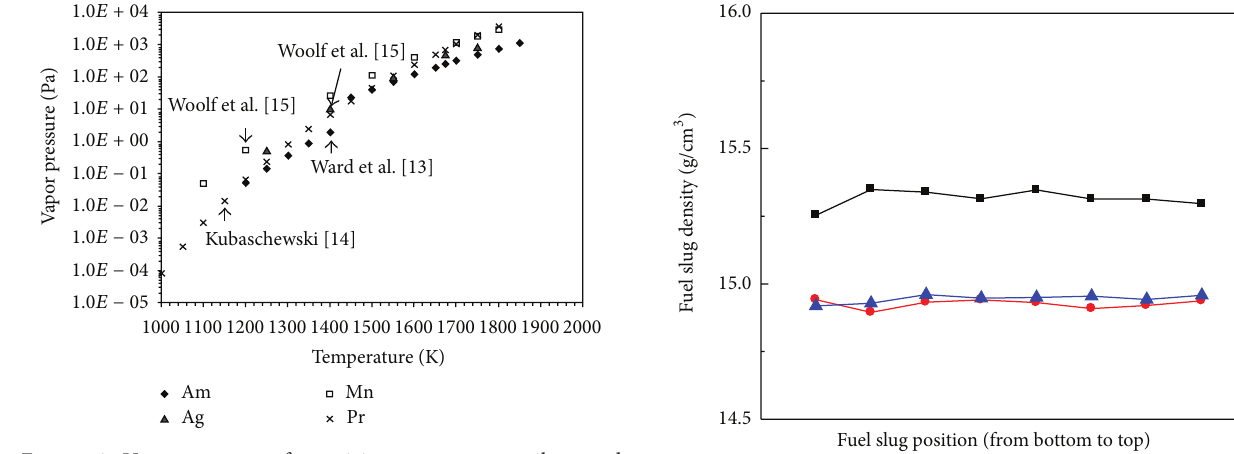
Figure 3: Vapor pressure of americium, manganese, silver, and praseodymium as a function of temperature [7, 13–15].